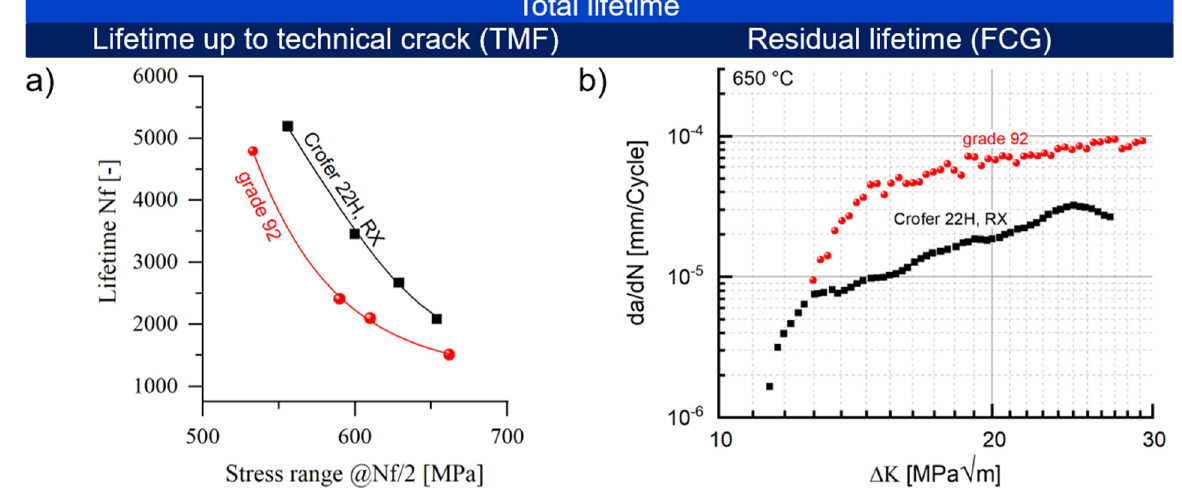
Figure 4. Total lifetime consisting of ( a ) the technical lifetime to cracking (characterized by (out of phase)-TMF lifetime ( ε mech = −ε th ., Δ T = 50 − 650 °C, dT/dt = 10 Ks − 1 , th = 0 at T min and T max [15]) and ( b ) residual lifetime (characterized by the crack propagation rate; 650 °C, R = 0.1 f = 20 Hz) of Crofer ® 22H, RX and grade 92 [15].